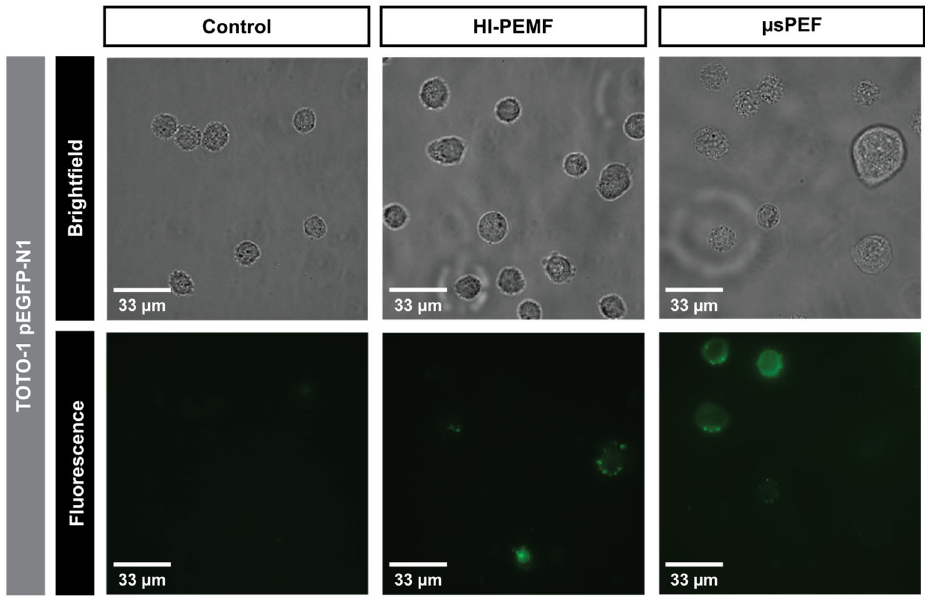
Figure 1. pDNA interaction with cell membrane after the application of HI-PEMF and µ sPEF. Images of brightfield and fluorescence taken under the microscope with 500 µ g/mL of TOTO-1 labelled pEGFP ‐ N1.